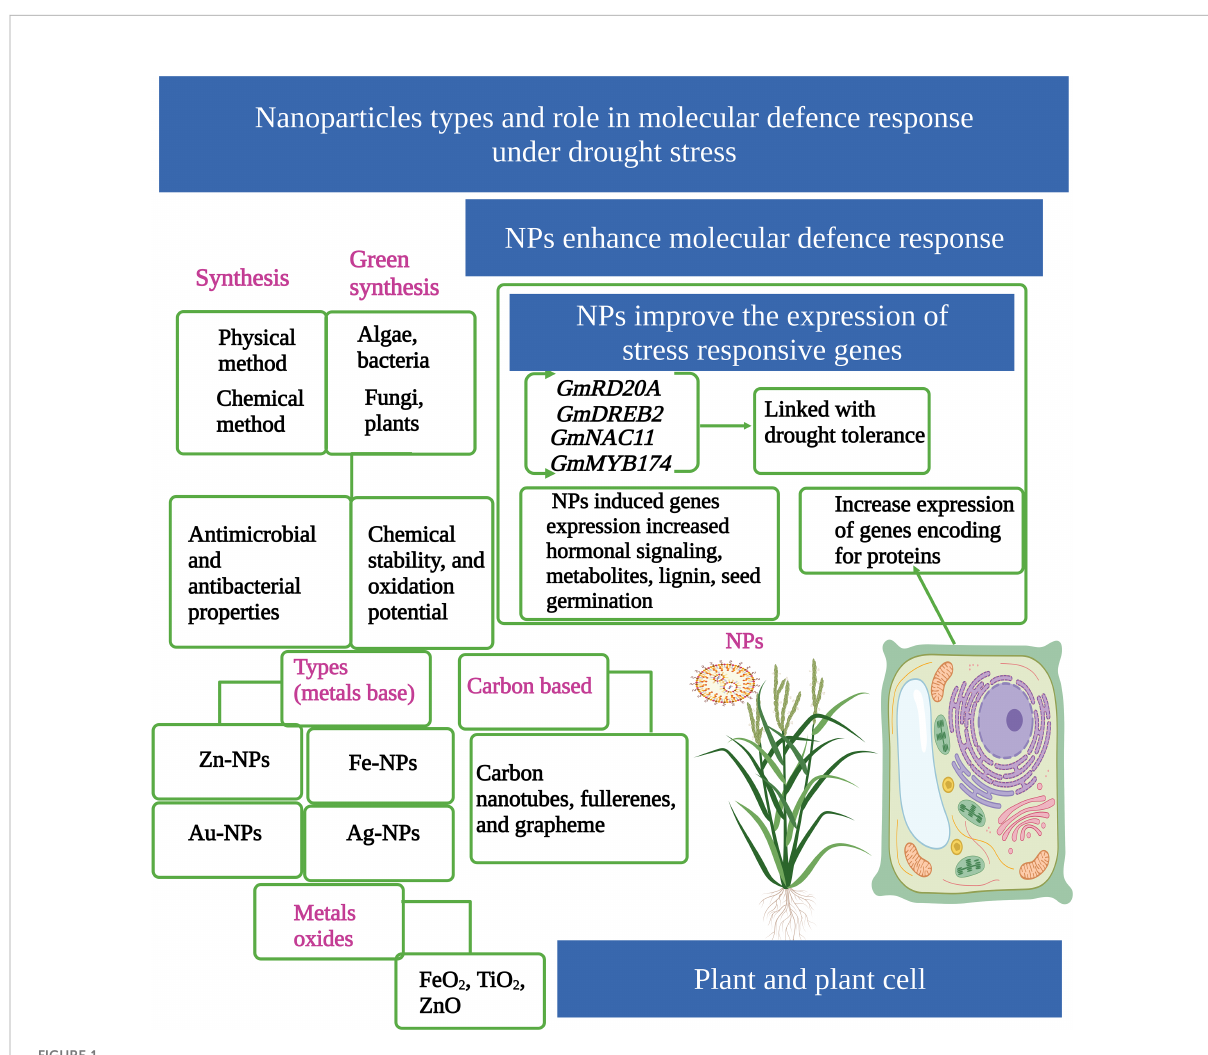
FIGURE 1 Nanoparticles (NPs) play a key role in drought tolerance in plants. NPs can be prepared by two main methods (physical or chemical). Green synthesis of NPs is an environmentally friendly technique. There are different groups of NPs, such as metal-based, metal-oxide-based, and carbon-based NPs. NPs increase the expression of genes under drought stress (DS) and protect plants from toxic effects. This Figure is created with